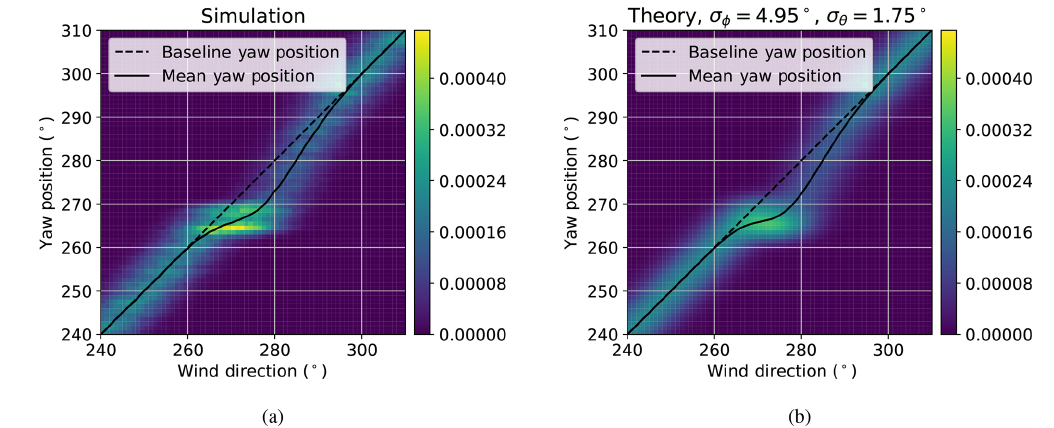
Figure 8. Distributions of low-frequency wind direction and yaw position with yaw offset control using a dynamic-optimal yaw offset schedule: (a) histogram from simulation results and (b) theoretical probability density function assuming wind direction uncertainty with a standard deviation of 4.95 ◦ and yaw position uncertainty with a standard deviation of 1.75 ◦ .